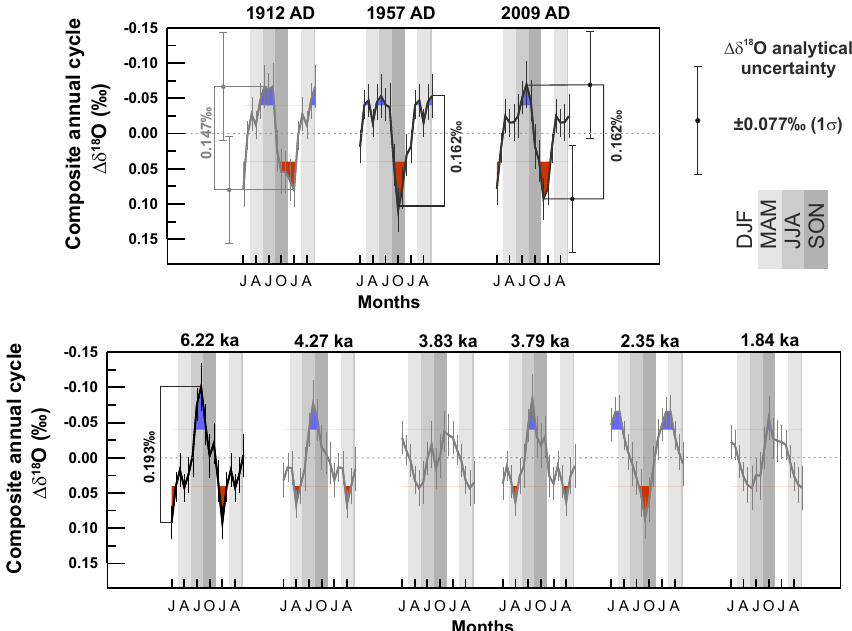
Fig. 6. Composite annual coral 1δ 18 O cycles for three modern (top panel) and six fossil (bottom panel) corals calculated using the centering method (Cahyarini et al., 2008) and Sr/Ca-SST and δ 18 O–SST relationships of − 0.061mmolmol − 1 ◦ C − 1 and − 0.180‰ ◦ C − 1 (Corr`ege, 2006; Gagan et al., 1998). Combined analytical uncertainty is 0.154‰ (2 σ ). Composite annual cycles represented in black (gray) are characterised by an amplitude of the annual 1δ 18 O cycle higher (lower) than 2 σ . Vertical gray shading indicates seasons: winter (December– February, DJF), spring (March–May, MAM), summer (June–August, JJA) and fall (September–November, SON). Negative and positive deviations from the mean value greater than 0.4‰ are indicated by blue and red colours,